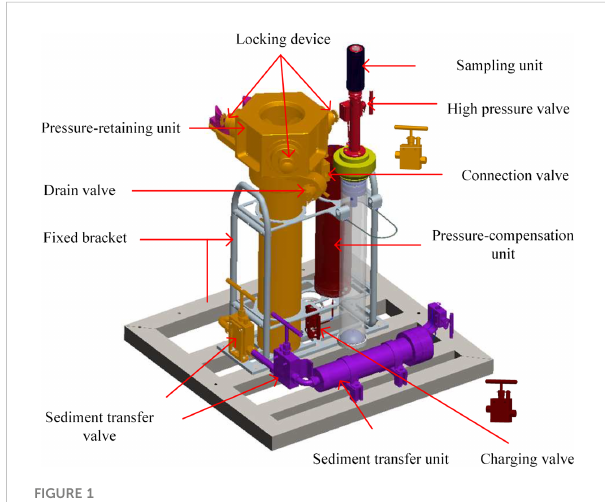
FIGURE 1 Structure scheme of the sediment